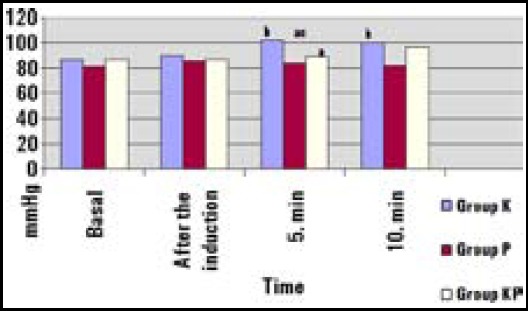
Mean arterial pressure of the groups (mmHg). aSignificant decrease compared with Group K, cSignificant decrease compared with Group KP, bSignificant increase compared with basaline